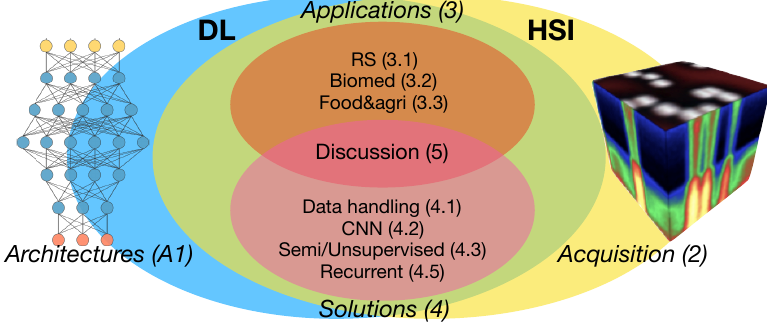
Figure 1. Graphical structure of the